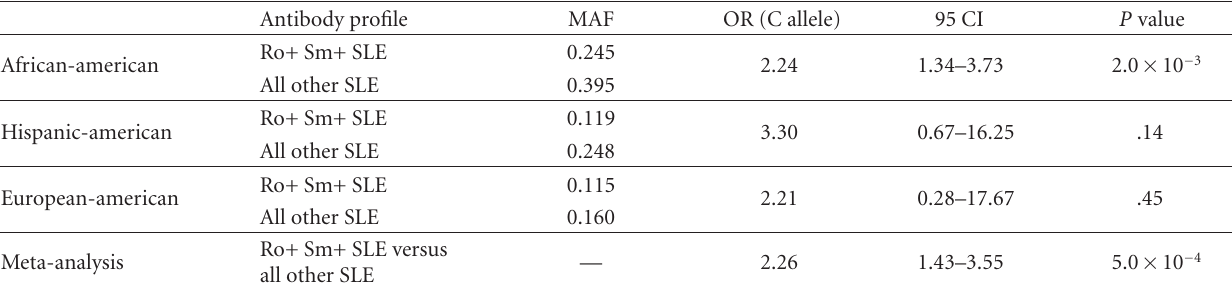
Table 2: Association of the rs3813065 C allele with anti-Ro and anti-Sm positive patients in each ancestral background. Antibody profile